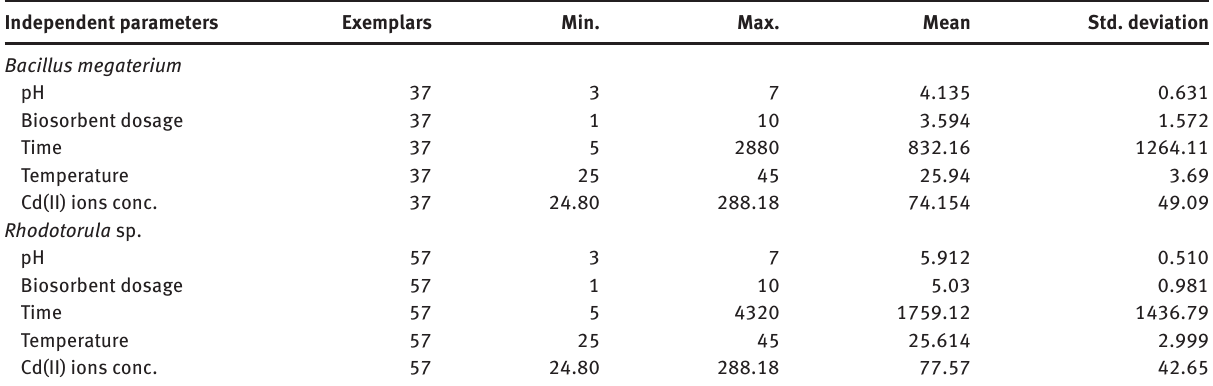
Table 3: Descriptive statistics of the experimental data.